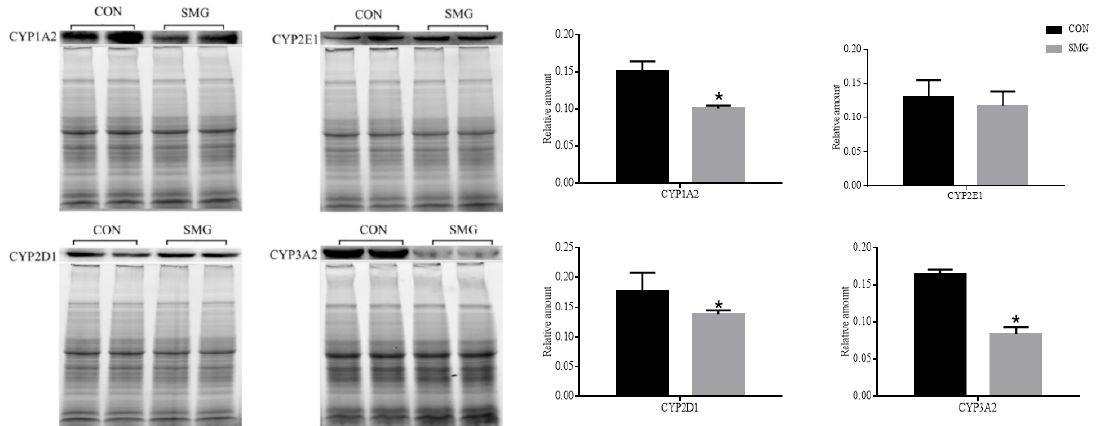
Figure 6. Western-blot of CYP1A2, 2E1, 2D1, 3A2 in rats’ small intestines under 14 d SMG. Compared with the CON group, * p < 0.05.